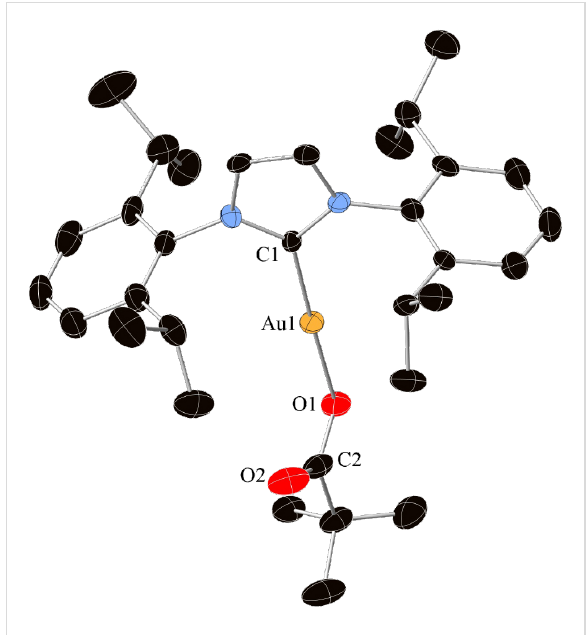
Figure 1: X-ray structure of [Au(OPiv)(IPr)] 3 . Thermal ellipsoids are shown at the 50% probability level. H atoms are omitted for clarity. Selected bond distances (Å) and angles (°) for 3 : Au1–C1 1.978(5), Au1–O1 2.048(4), O1–C2 1.299(8), C2–O2 1.231(9), C1–Au1–O1 178.0(2), Au1–O1–C2 120.7(4), O1–C2–O2